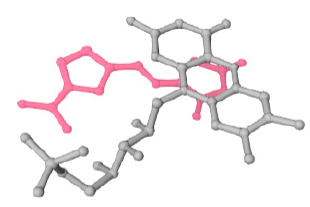
Figure 4. The orientation of nitrofurantoin ( pink ) and FMN ( gray ) in the complex of nitrofurantoin with oxidized E. coli NfsA. The structure is taken from the Protein Data Bank, accession code 7NB9 [142].